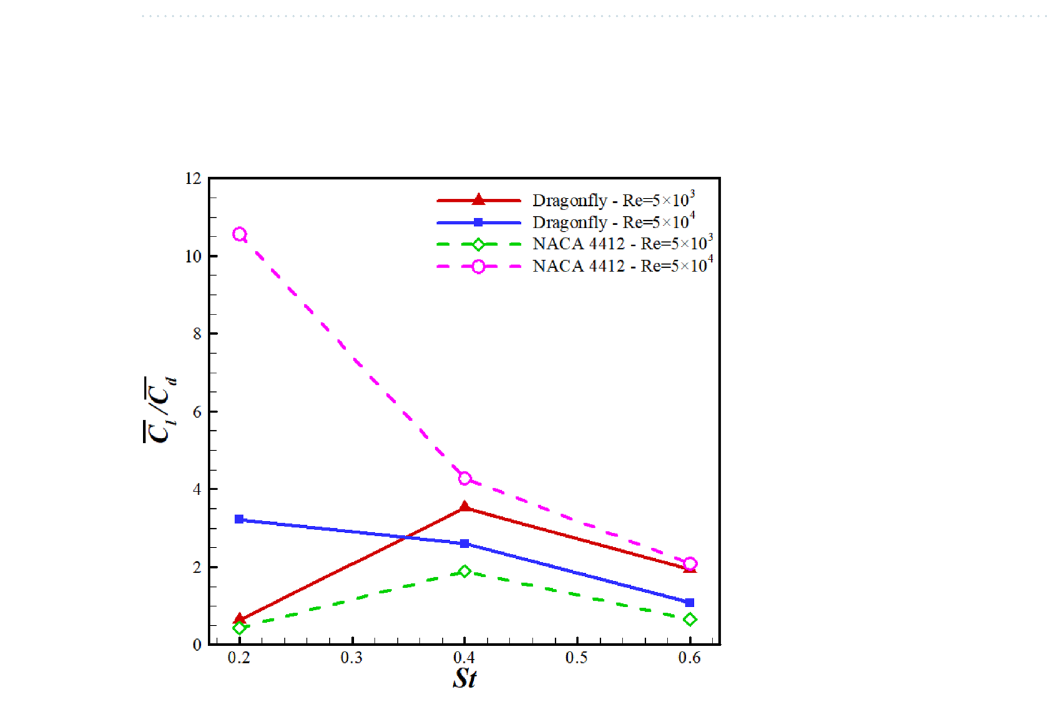
Figure 17. Contours of momentary velocity coefficients across a cycle with Re = 5 × 10 dragonfly and NACA4412 airfoils.